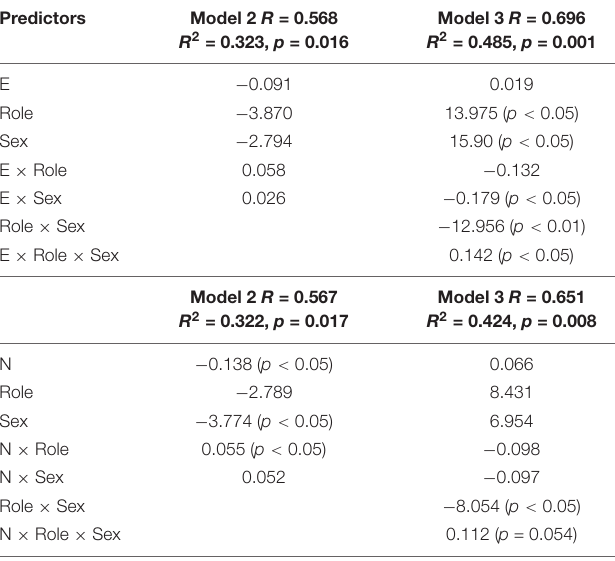
TABLE 3 | Unstandardized beta coefficients and model indices. Predictors